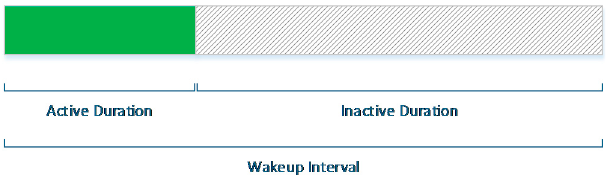
Figure 3. Time structure of IEEE 802.15.5 energy-saving mechanisms.